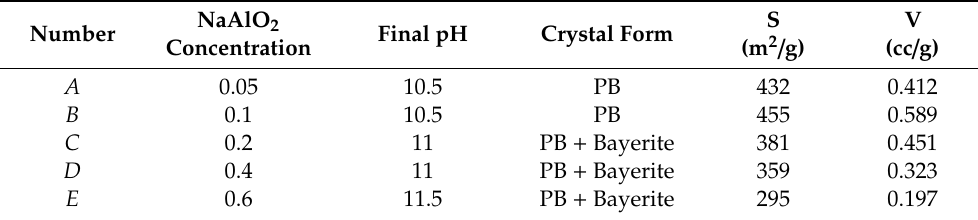
Table 2. The pore properties of pseudo-boehmite (PB) under di ff erent concentrations of NaAlO